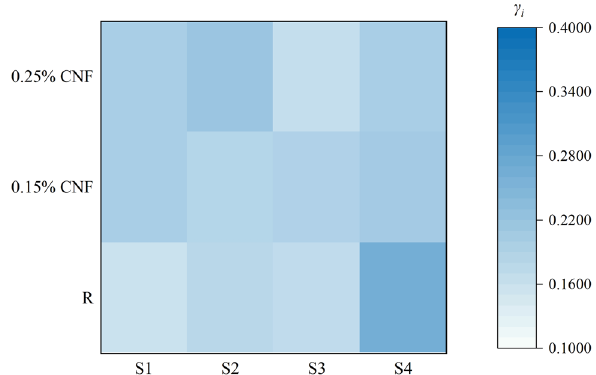
Figure 13: Steel fi ber local distribution on the cutting cross - section of UHPC. The aggregation and vacancy of steel fi bers are distin - guished by the depth of blue colors. The darker color indicates that large amounts of steel fi bers are dispersed in the